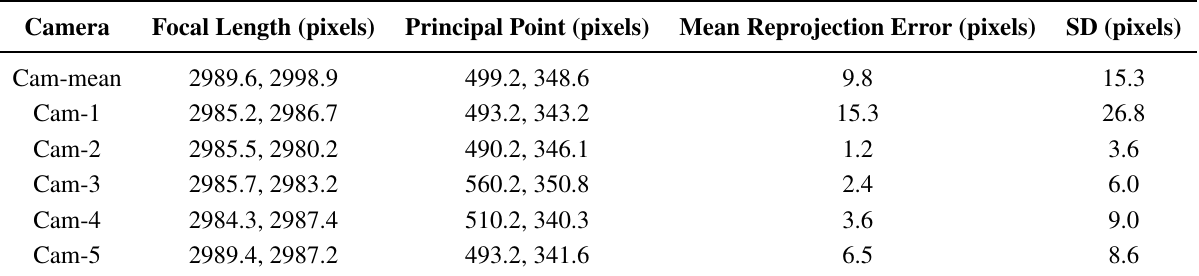
Table 3. Estimated internal camera parameters for the FME scenario.